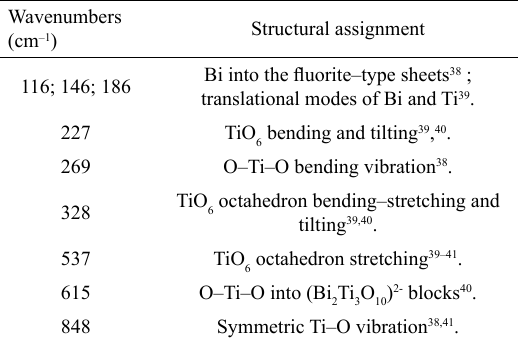
Electron diffraction demonstrated distinct spots, which is a remarkable characteristic of agglomerates of nanocrystals. The spots were indexed to Fmmm- Bi